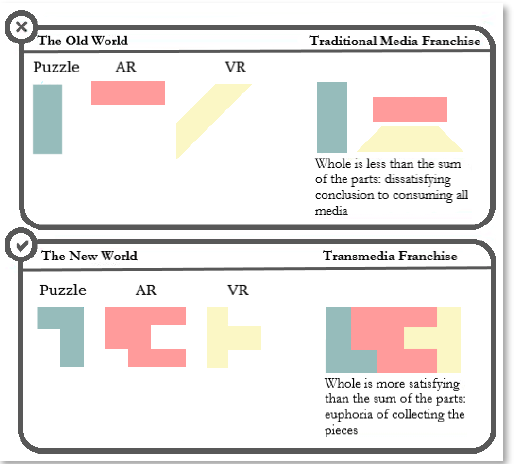
Figure 5. WUIM transmedia educational project ( source : adapted from Pratten [73] (p. 3)). WUIM deals with a real-life situation: learning the morning routine at home. The